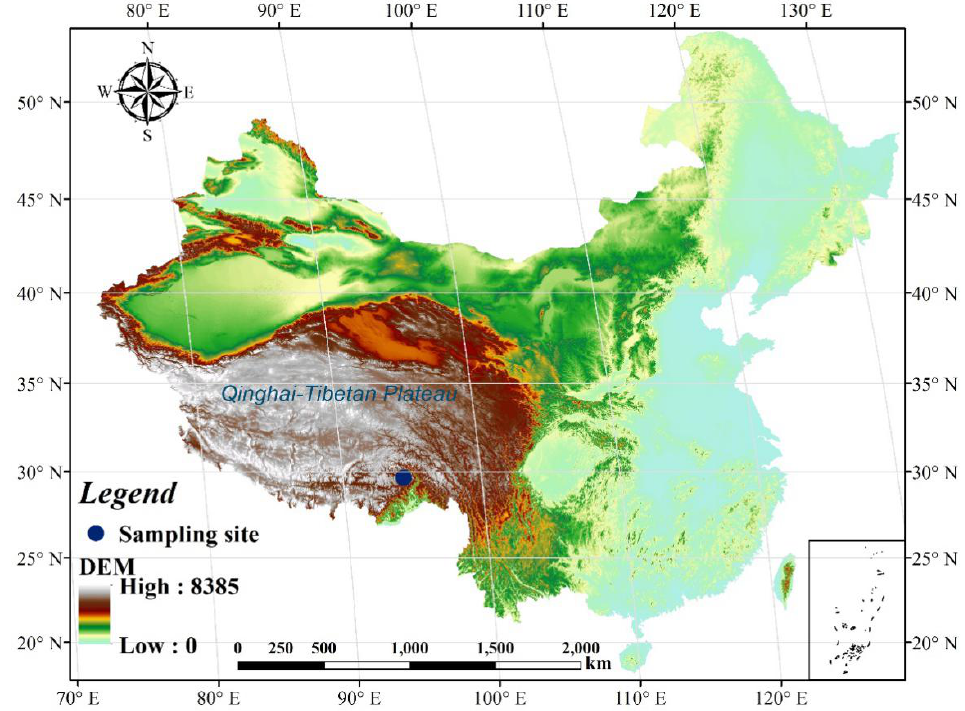
Figure 1. Location of the study site in Milin County (93°25′ E, 29°50′ N, 2900 m a.s.l.) near the Nyingchi City, the Tibet Autonomous Region, China.